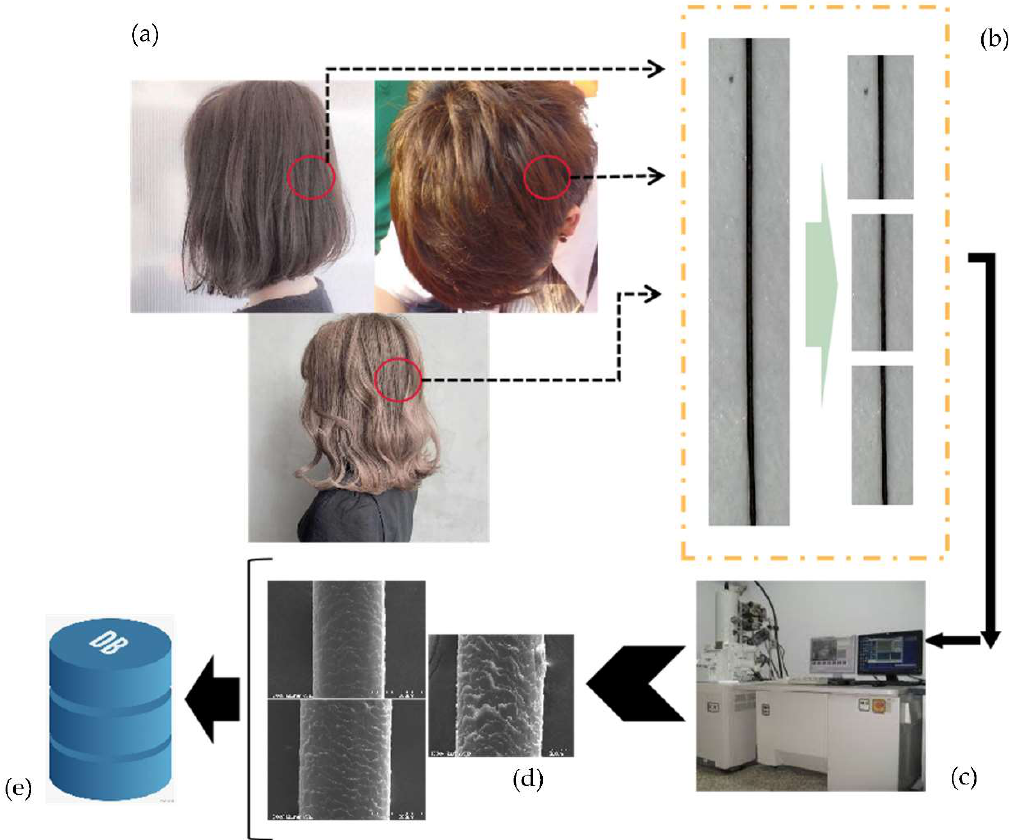
Figure 2. The processing of hair damage data collection, ( a ) is the many style of hair, ( b ) is the samples divided into three parts, ( c ) is the data collected on scanning electron microscope, ( d ) is the SEM image of hair, ( e ) is the many SEM hair images made into a DHI dataset.